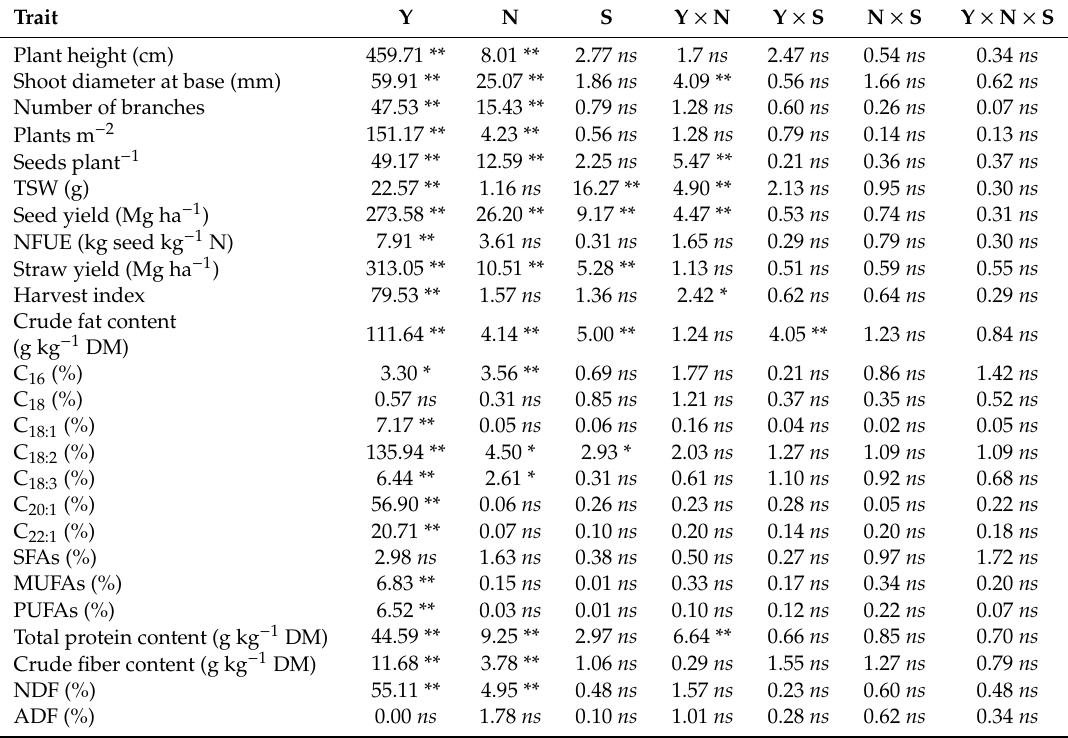
Table 2. F -test statistics in